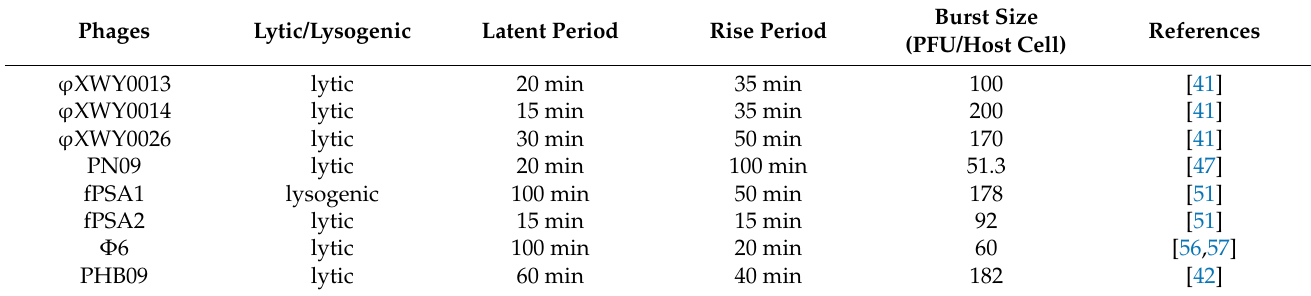
Table 2. The lytic activity of the representative Psa